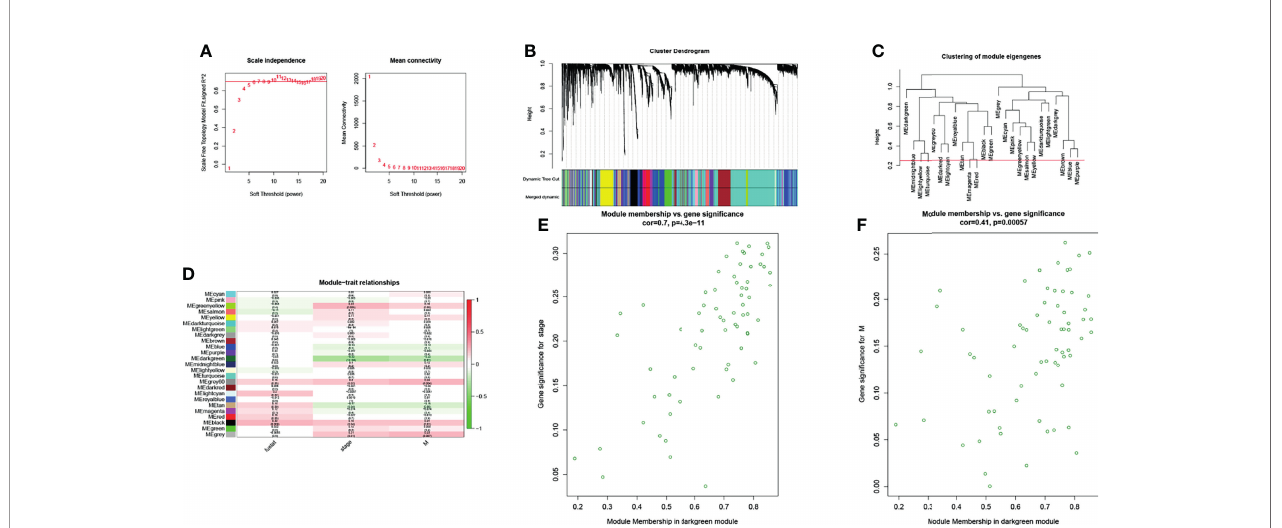
FIGURE 1 | The WGCNA R package was used for fi nding clusters (modules) of highly correlated genes. (A) Scale-free fi tting index and the average connectivity at different soft threshold powers were analyzed. In summary, 5 was the most suitable power. (B) The co-expression module was created. Each branch represents a gene, and each color below represents a co-expression module. (C) Cluster dendrogram of module eigengenes. (D) Heatmap analysis of the correlation between module characteristic genes and traits showed that the dark green module negatively correlated with stage and distant metastasis of patients with CRC (absolute value of cor >0.2, p < 0.05). (E, F) Scatter plot of dark green module members (MM) and gene signi fi cance (GS). A signi fi cant correlation was found between GS and MM (cor >0.4, p <